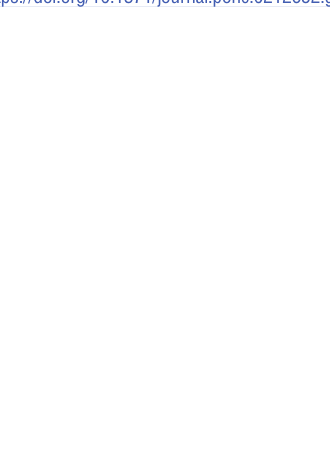
PLOS ONE | https://doi.org/10.1371/journal.pone.0212652 October 4,